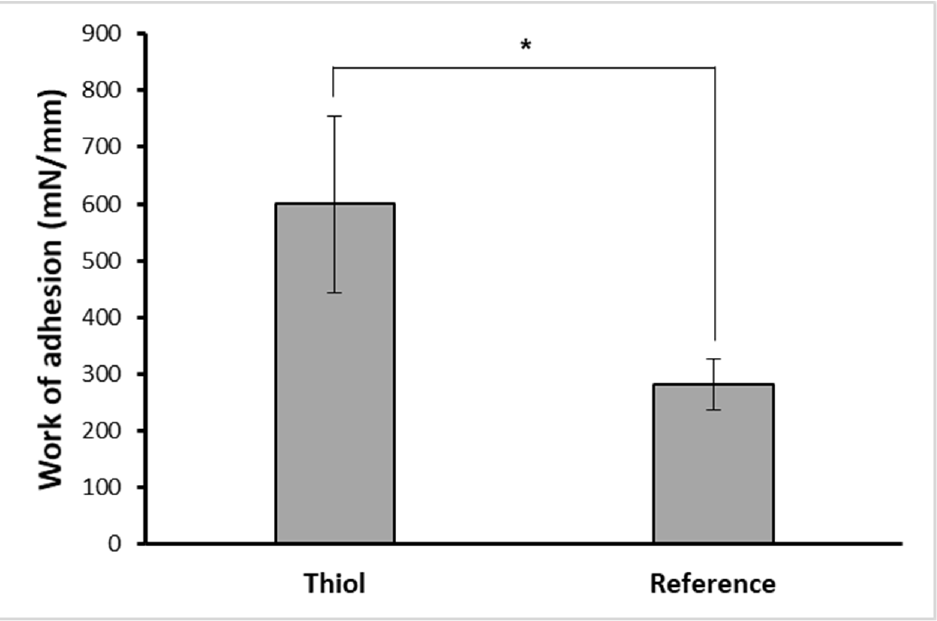
Figure 7. The work of adhesion of mucoadhesive thiolated hydrogel (2% w / v ) and reference hydrogel (2% w / v ) using pig intestinal membrane, * asterisk means significant difference ( p < 0.05).